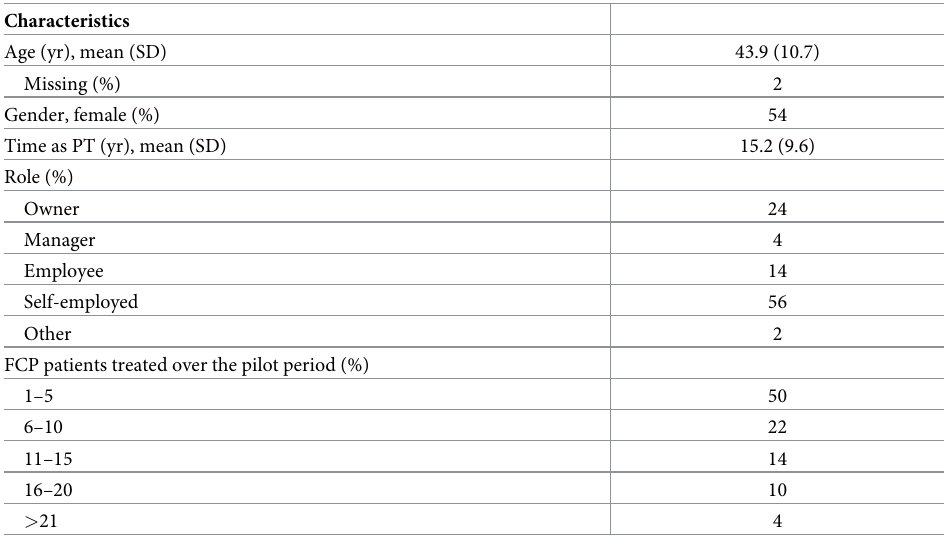
Table 1. Characteristics of the physiotherapists that completed the survey (n = 50) about using the PhysDB-FCP in patients with receiving FCP.